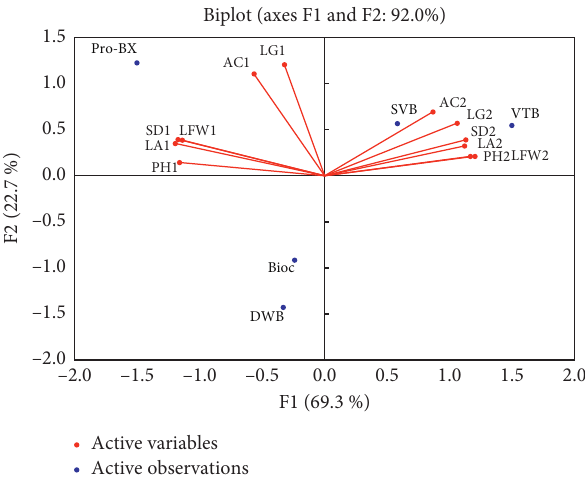
Figure 5: A two-dimensional principal component analysis biplot showing relationships among media treatments as active variables and plant growth components as active observations. Plant growth components were leaf greenness (LG), anthocyanin content (AC), plant height (PH), stem diameter (SD), leaf area (LA), and total edible leaf fresh weight (LFW) of Swiss chard ( Beta vulgaris subsp. vulgaris) cv. Rhubarb chard as affected by biochar alone (Bioc), deionized water-inoculated biochar (DWB), solid vermicast-in- oculated biochar (SVB), vermicast tea-inoculated biochar (VTB), and Promix-BX alone (Pro-BX) at the first (1) and the second (2) harvests,